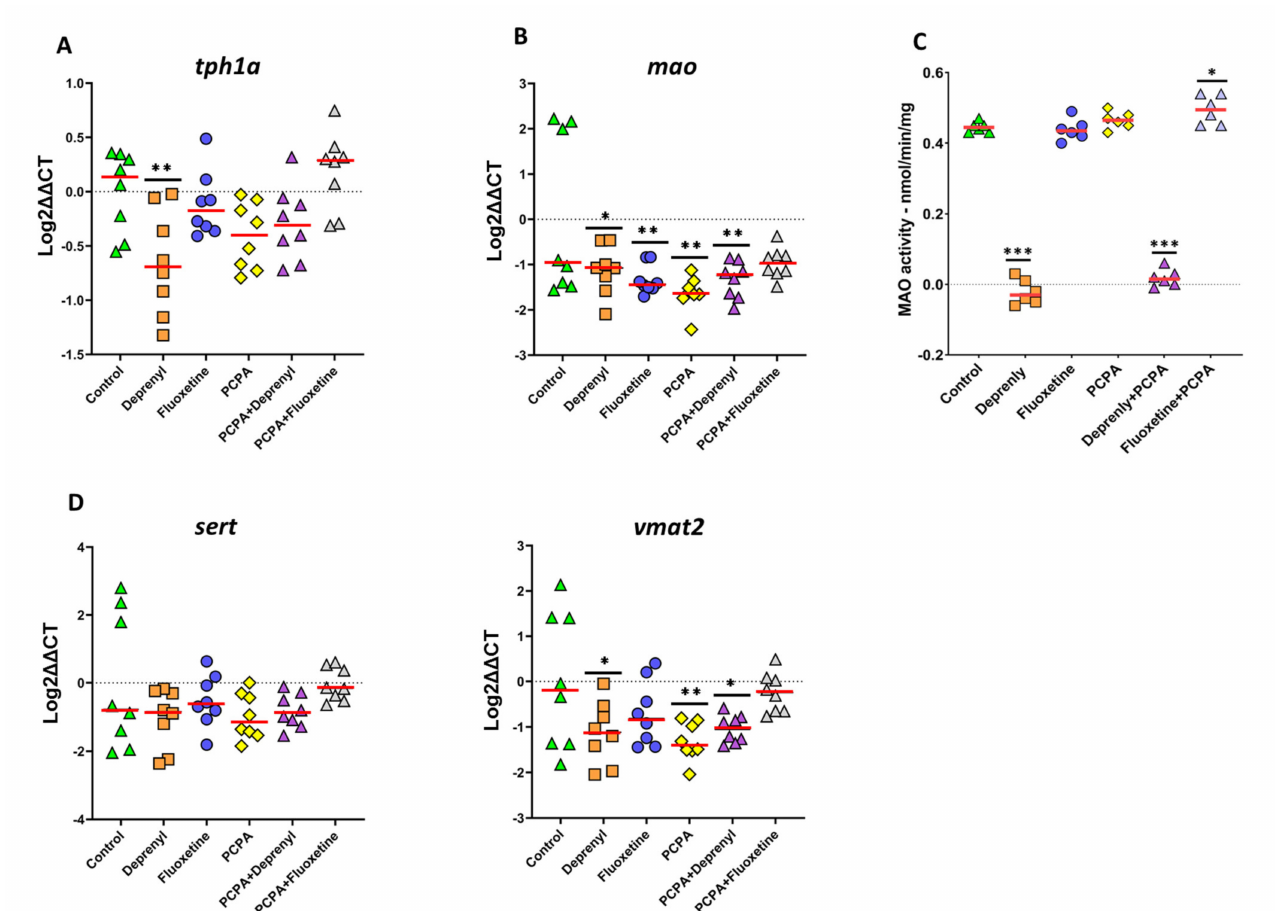
Figure 4. Effects over gene and enzyme activity levels in whole body of 8 dpf old zebrafish larvae following pharmacological modulation of the serotonergic system. ( A ) Expression of tph1 α involved in serotonin synthesis process; ( B , C ) Expression of mao and MAO activity, respectively, involved in the degradation of serotonin; ( D ) Expression of sert and vmat2 genes that respectively regulate serotonin transport from the synaptic cleft back to the presynaptic neuron and the transport of serotonin form the cell cortisol into synaptic vesicles. Data are from 2 independent experiments and are reported as scatter plots with the median (red line) and n = 6–8 for all treatment groups. Significance was set to p < 0.05 and can be represented as * when p < 0.05; ** when p < 0.01 and *** when p < 0.001, one-way ANOVA with Dunnett’s multiple comparison